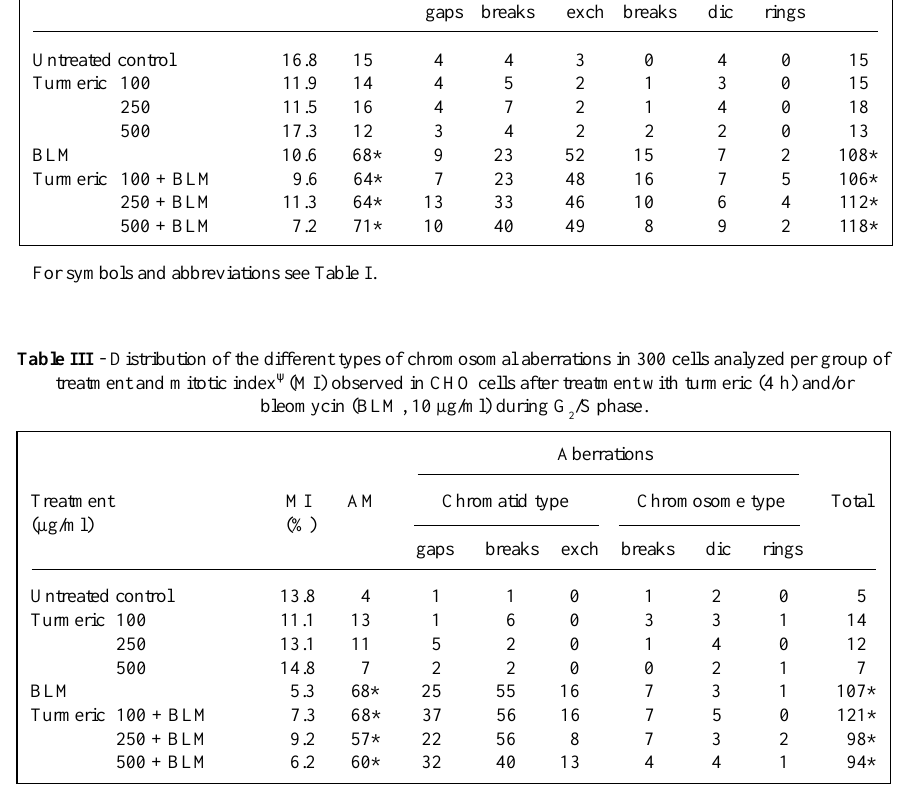
Table II - Distribution of the different types of chromosomal aberrations in 300 cells analyzed per group of treatment and mitotic index y (MI) observed in CHO cells after treatment with turmeric (9 h) and/or bleomycin (BLM, 10 µg/ml) during S phase.